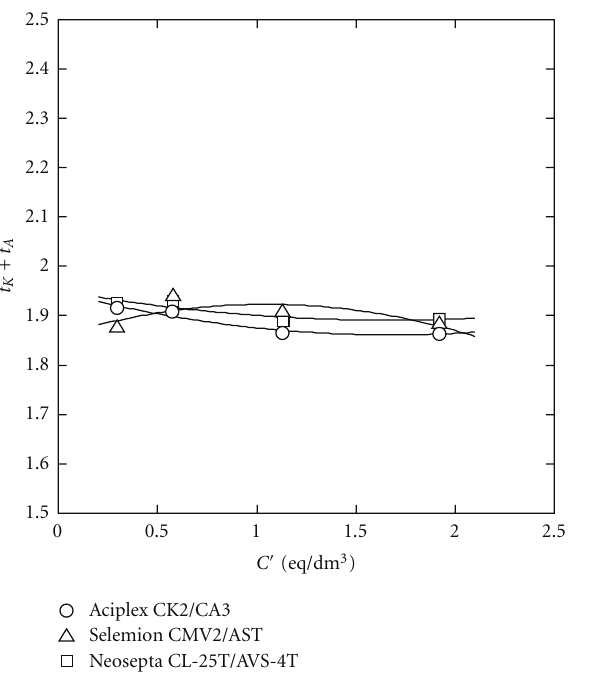
Figure 9: Relationship between salt concentration in a feeding solution and transport number.